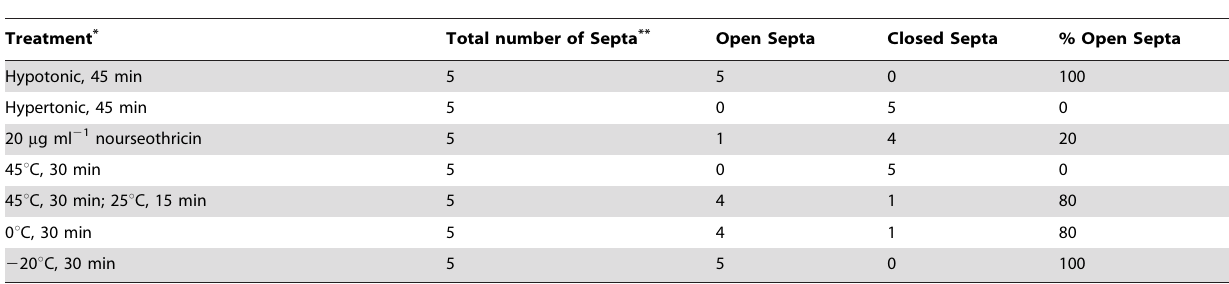
Table 2. Plugging of the apical septum depends on environmental